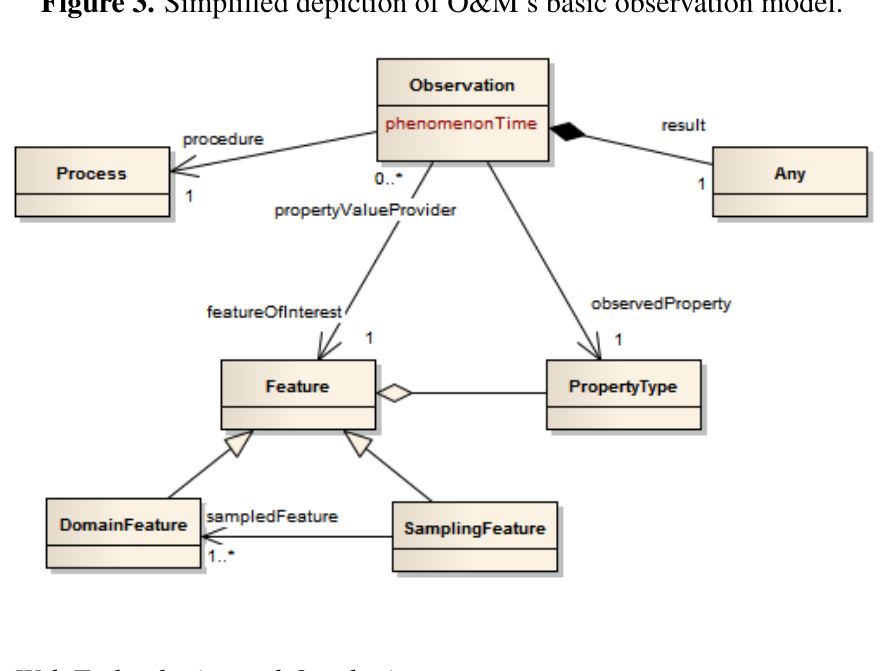
Figure 3. Simplified depiction of O&M’s basic observation